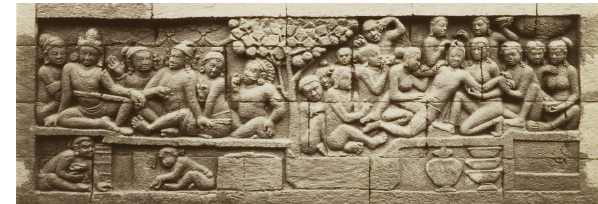
Figure 1. An example of old photos taken in 1890 digitize surfaces into point cloud data. For the hidden parts, the hidden reliefs are reconstructed into point clouds from their monocular gray-scale photos. Then the photogrammetry data of the visible parts and reconstructed data of the hidden re- liefs are combined after a coordinate transformation. After the stochastic point-based rendering is applied, the result provides see-through imaging of the entire temple as well as the appear- ance of reliefs which are supposed to be covered by stones, such combination is defined as fused transparent visualization in this paper. With fused transparent visualization, the hidden reliefs of Karmavibhangga can be clearly seen through the stone